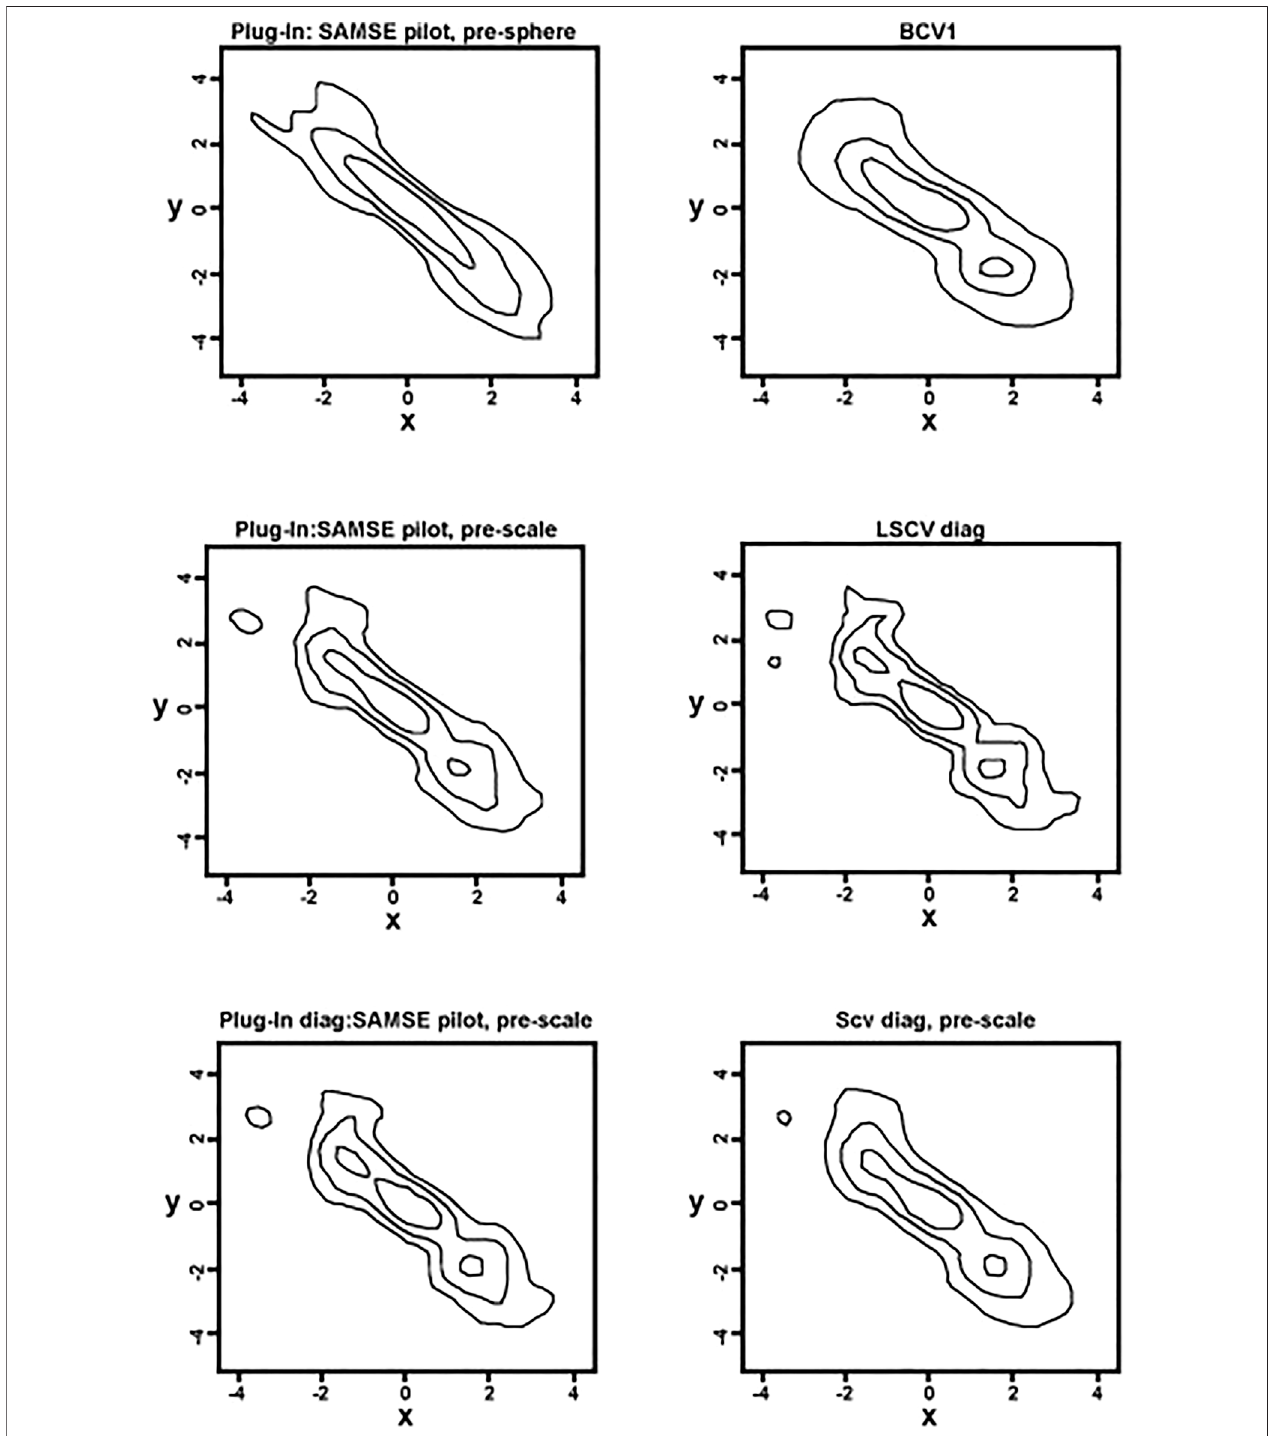
FIGURE2| SixexamplesofPDFscalculatedwithdifferentselectorsasindicatedontopofeachpanel.Thepanelswereselectedamongtheexamplespresentedin Figure 2 and Figure 3 of Duong 2007.